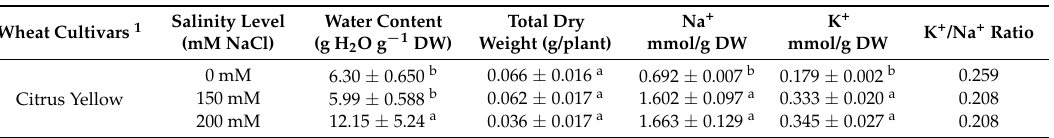
Table 2. Effects of different levels of salinity on total dry weight, shoot water content after 30 days of sowing of investigated wheat